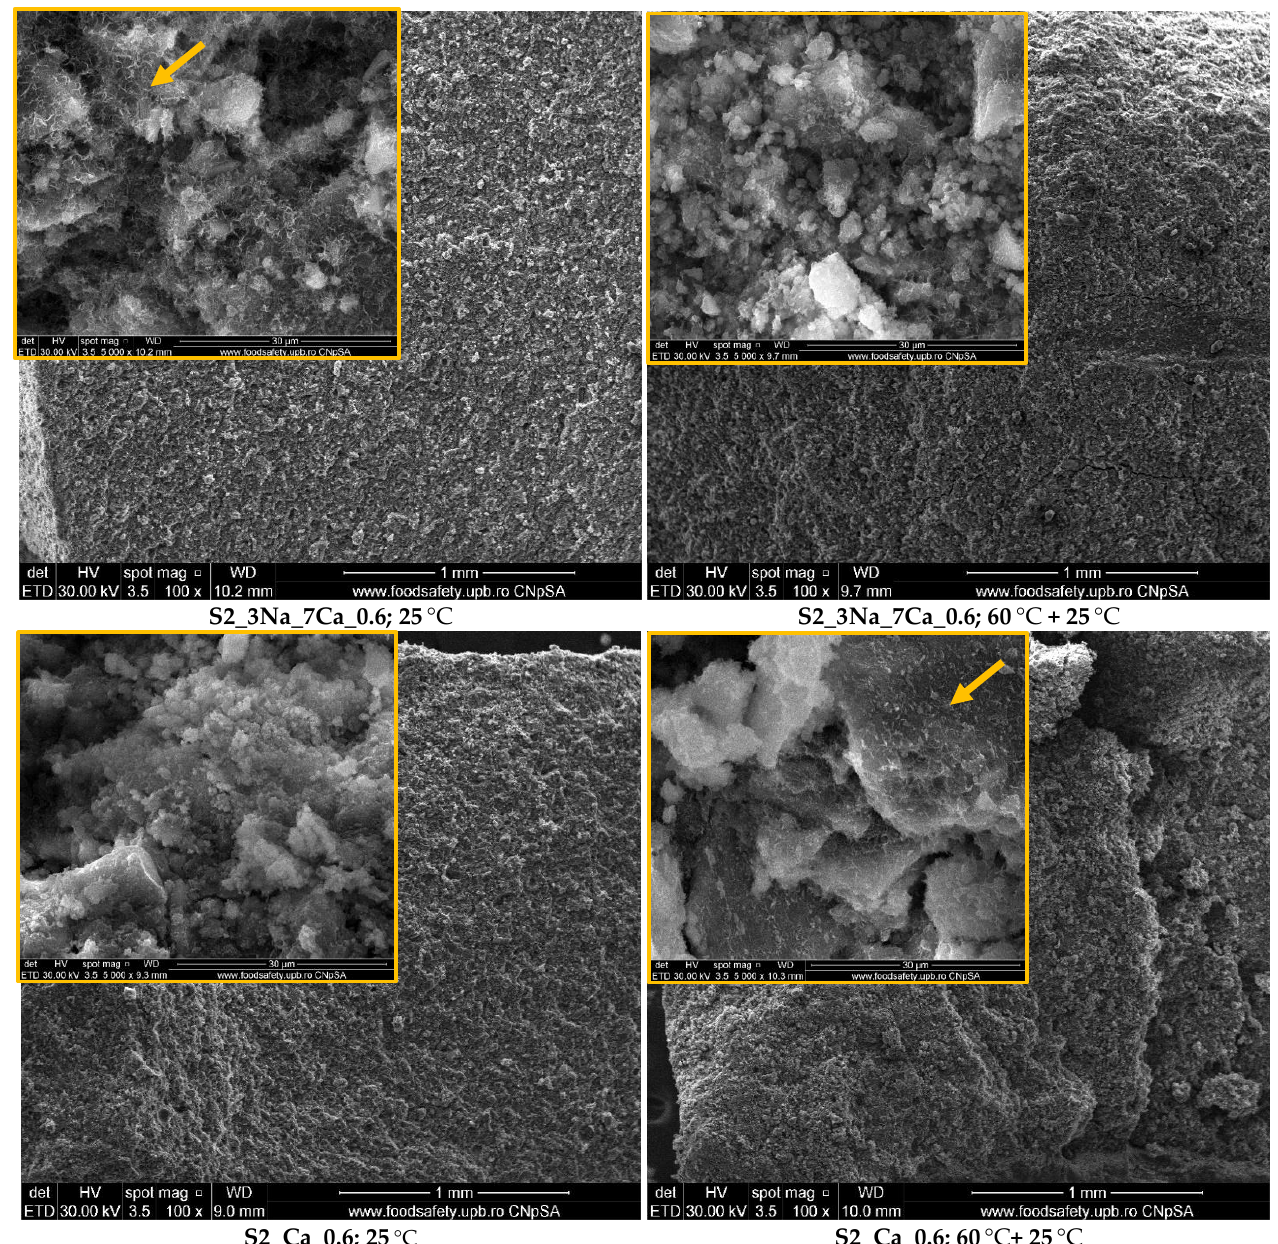
Figure 5. Electronic microscopy analyses (SEM) of samples based on S2 glass powder stored at 25 °C or at 60 °C for the first 24 h and then at 25 °C.